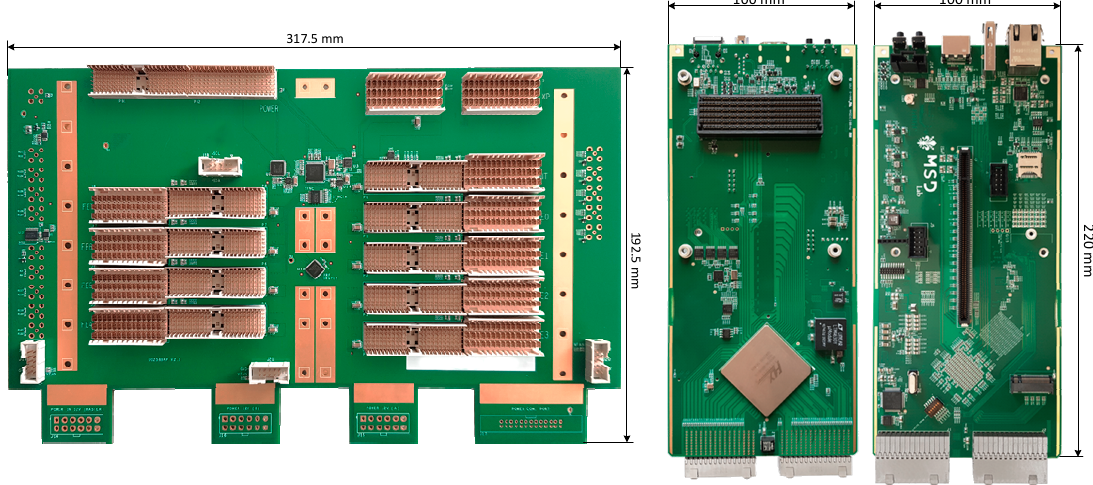
Figure 1. On the left, top view of the Back-Plane (BKP) board; on the right, top and bottom view of the expansion (EXP) board without the Jetson module assembled on it.